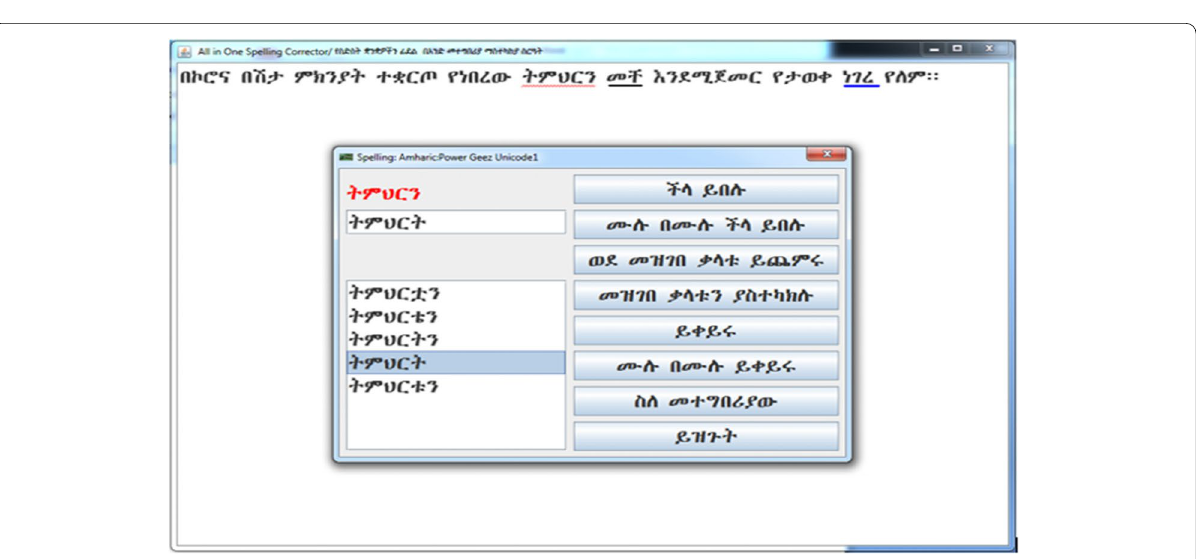
Fig. 9 Sample GUI model with a list of suggestions for a single